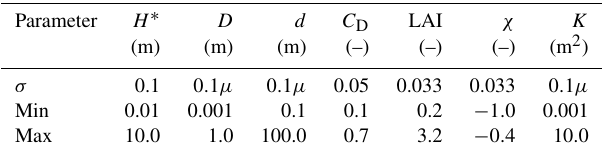
Table 3. Input parameter deviations and